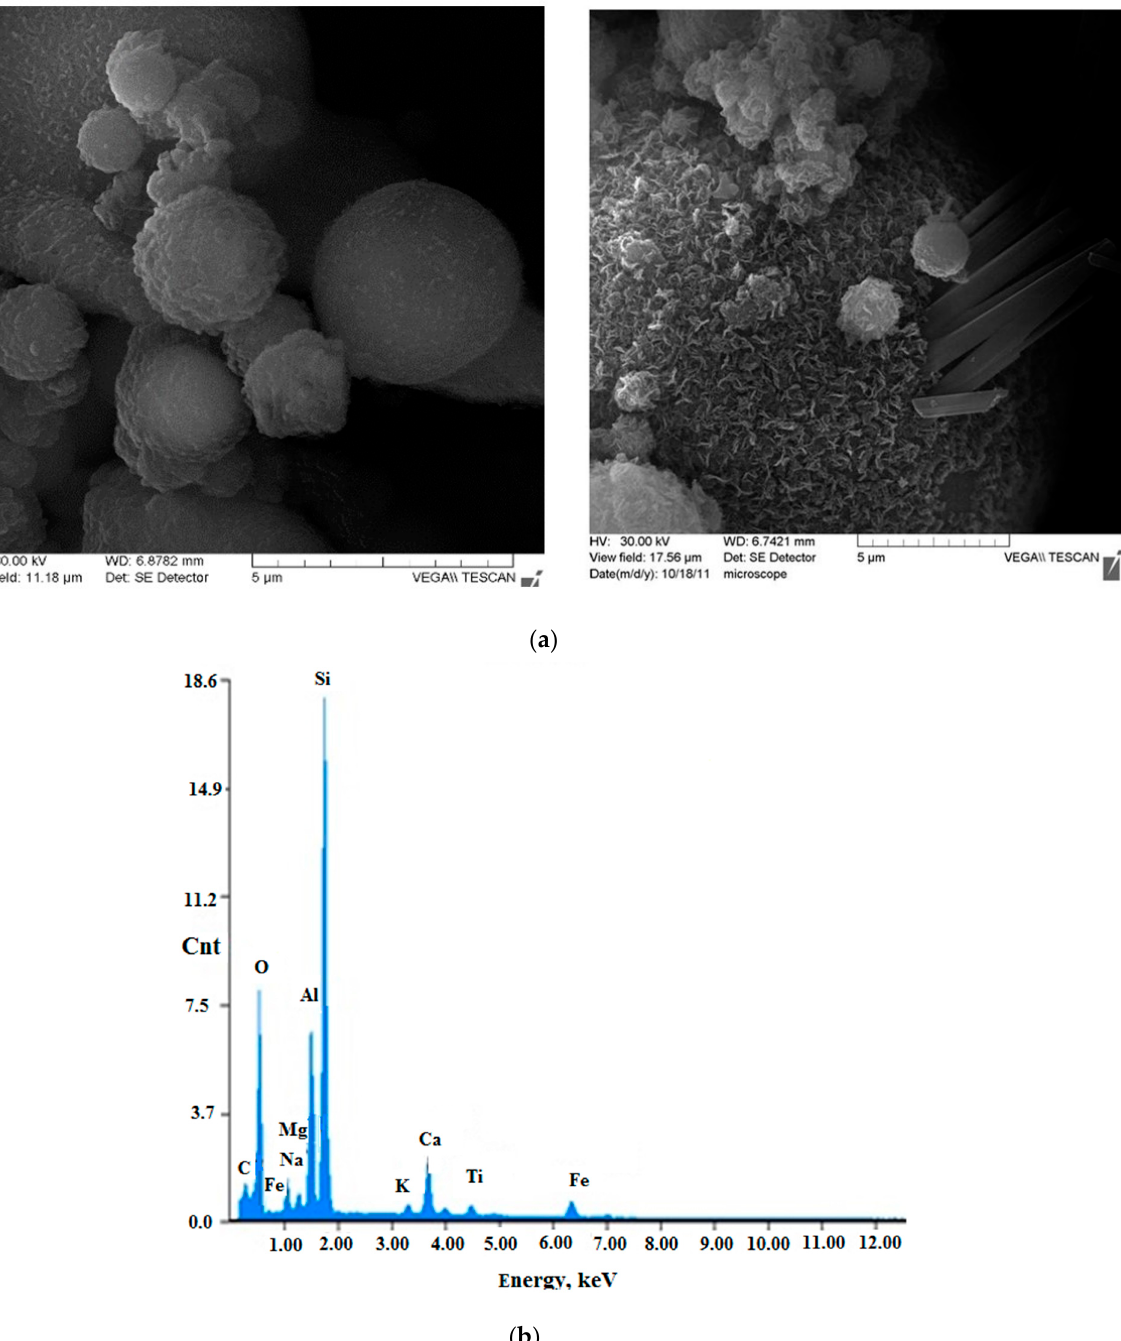
Figure 1. ( a ) SEM analysis of fly ash (FA) (left) and MFA (right); ( b ) EDX analysis of MFA. Table 2. The chemical composition determined by SEM/EDS